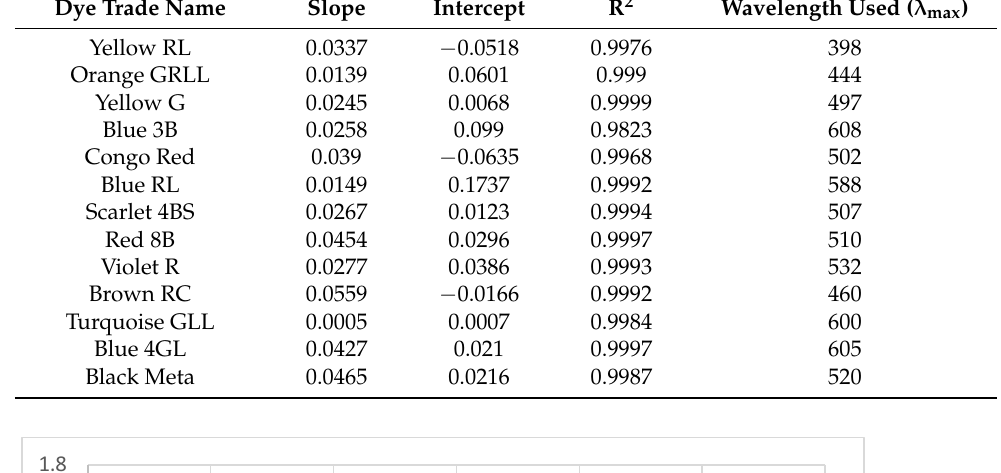
Figure 3. Absorbance vs. wavelength for Direct Yellow RL; the maximum absorbance is 396 nm.